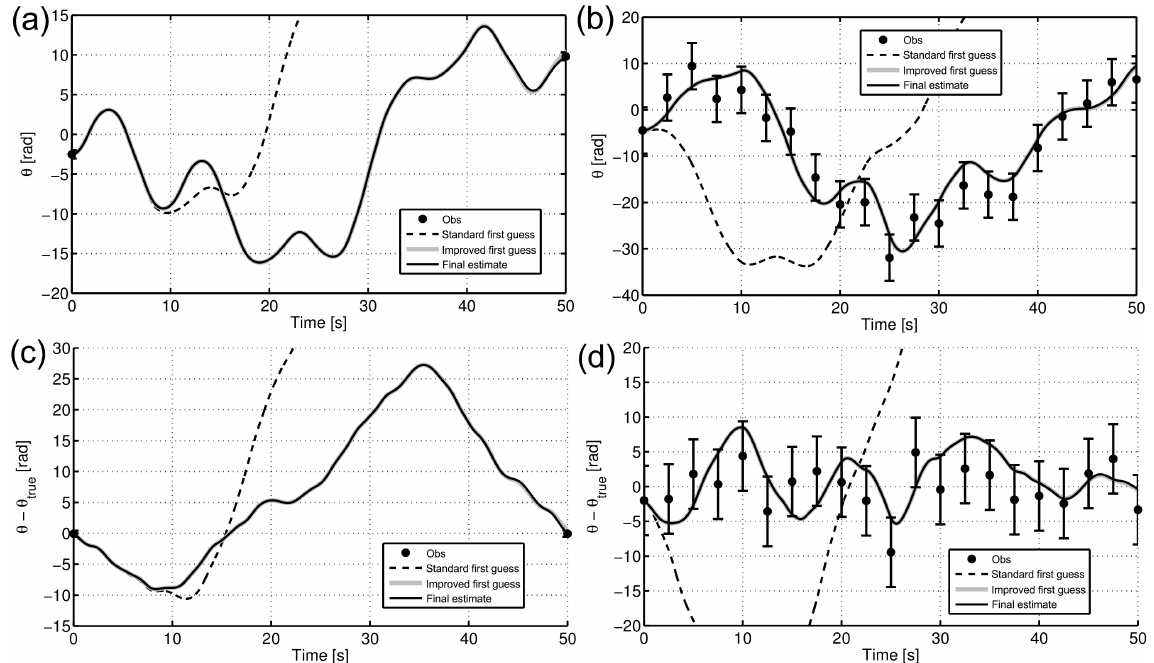
Figure 5. State estimation of the chaotic pendulum with a reduced set of two observations with standard error 0.5rad (a, c) and a set of 20 observations with standard error 5rad. (a, b) Comparison of the observations (circles with 1 σ error bars), the standard first-guess (dashed), the improved first-guess (gray solid line), and the final state estimate (solid black line), as in Fig. 3. (c, d) Similar to the top row, except all quantities are referenced to the truth, θ true , as in Fig. 4. Again the standard first guess is off scale for much of the time window. The improved first guess is nearly identical (and obscured) to the final estimate in all